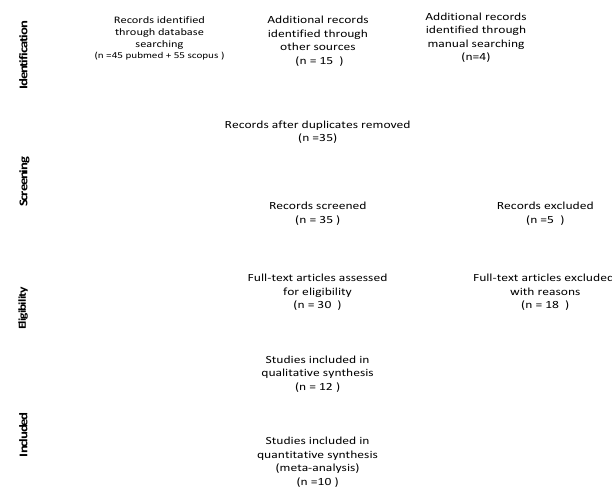
Figure 2. Prisma flow